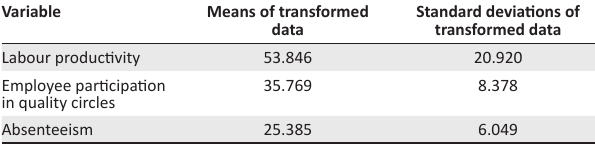
FIGURE 1: Bartlett’s test for homogeneity of variances. TABLE 5: Bartlett’s test for homogeneity of variances ( p = 0.001).